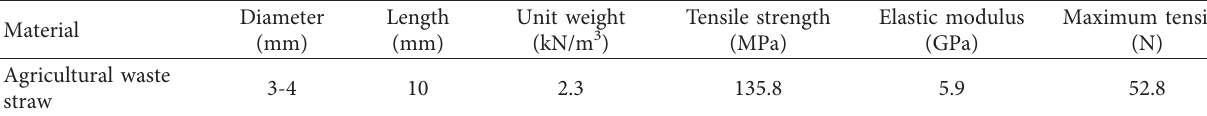
Figure 1: Particle-size distribution curves for Lantian loess. Table 2: Physical and mechanical properties of agricultural waste straw.